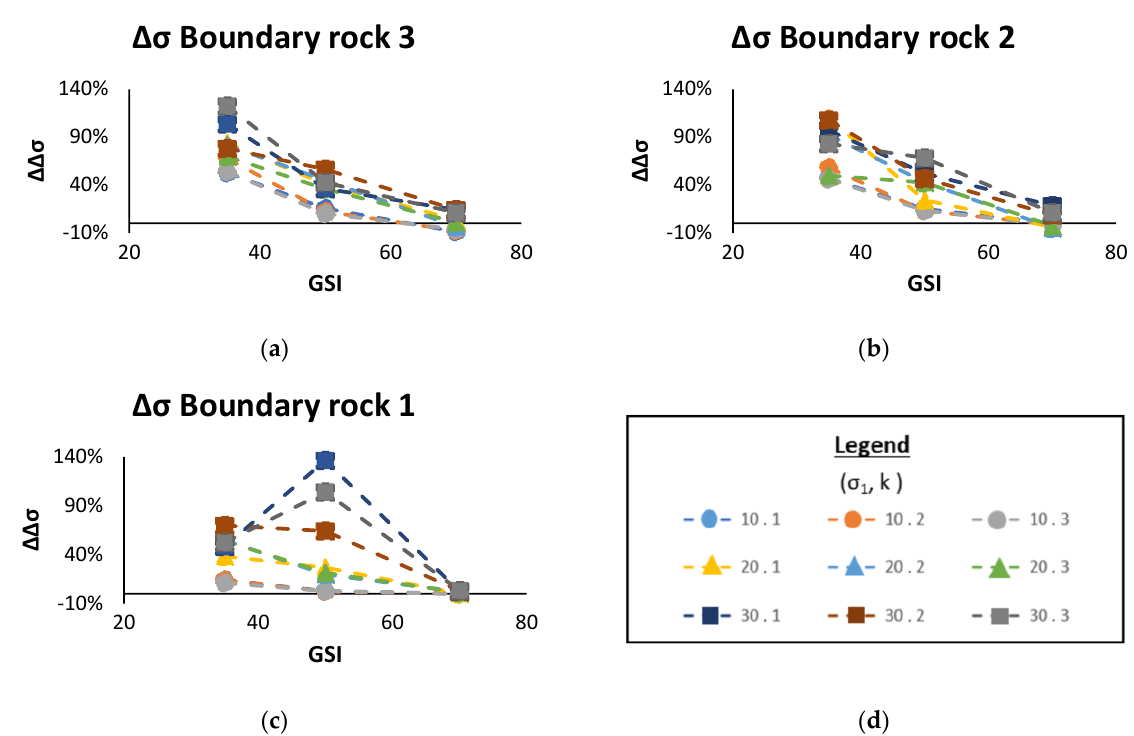
Figure 11. Variation of the relative deviation of the maximal differential stress at the boundary of the excavation for the stress states of Table 3 with an increasing GSI, ( a ) boundary rock 3, ( b ) boundary rock 2, ( c ) boundary rock 1, ( d ) legend.